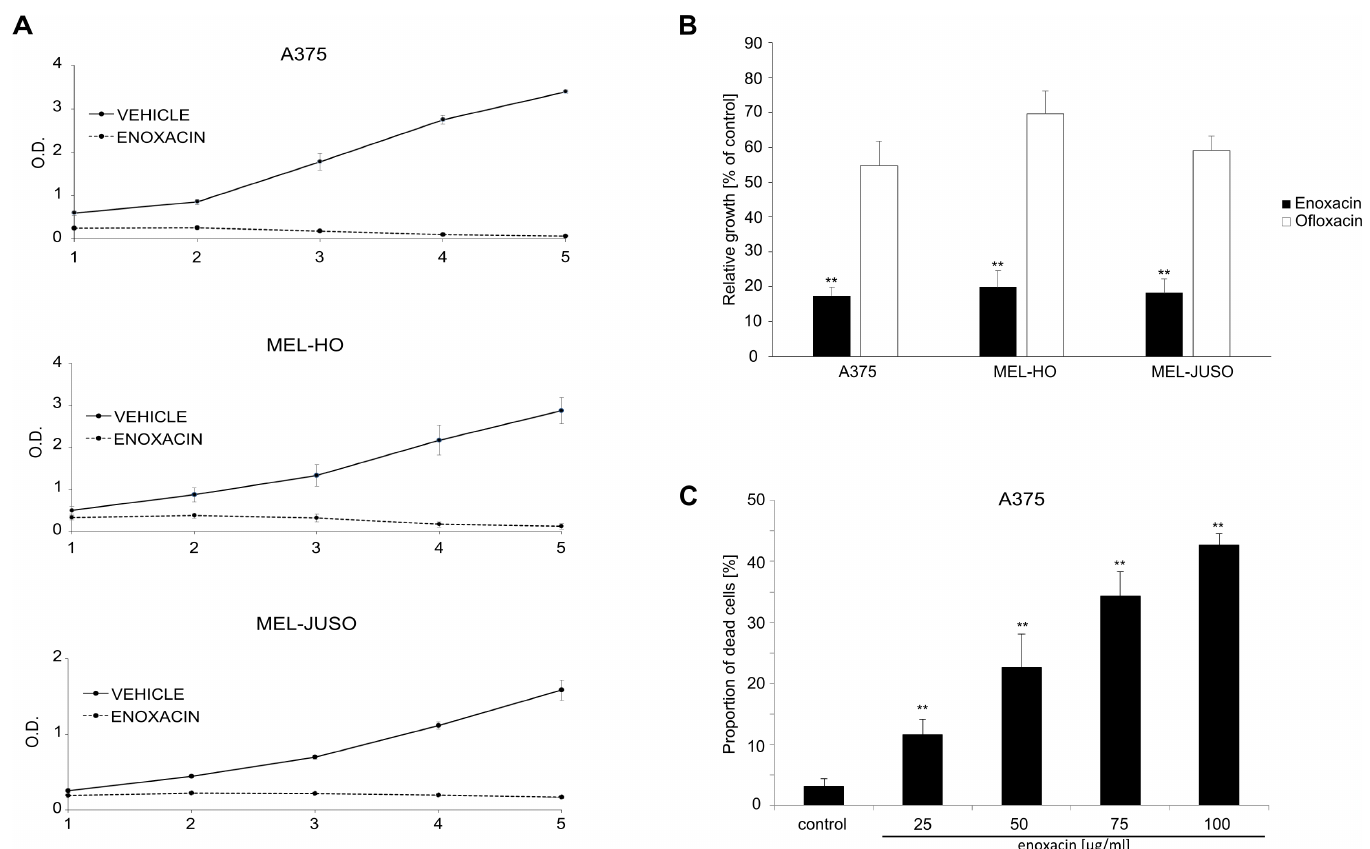
Fig 1. Enoxacin inhibits melanoma cell growth. ( A ) Melanoma cell lines were grown in the presenceof enoxacin(50 μ g/ml) or 0.2% NaOH (vehicle, negativecontrol). Relativecell growth was determined using standard MTT assay after 1, 2, 3, 4, and 5 days. Results of three independentexperiments are presented (means +/- SD). ( B ) Melanomacell lines were grown in the presenceof 0.2% NaOH (control), enoxacinor ofloxacin(both 50 μ g/ml) for four days and relative cell growth was determined by MTT assays. Results of three independentexperiments (means + standard deviations) are presented.A significantdifference between the effect of enoxacinand ofloxacin ** P < 0.01(Student’s t-test, two-tailed). ( C ) A375 cells were grown for 3 days in the presenceof 0.2% NaOH (control) or enoxacinin concentrations 25, 50, 75, and 100 μ g/ml. Cell viabilitywas determined using